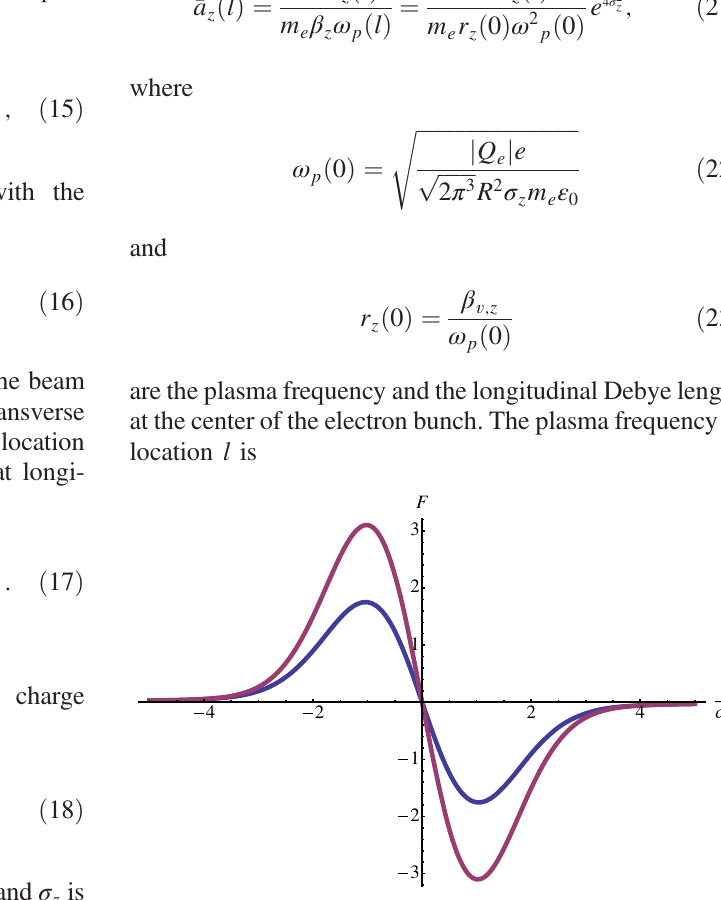
parameters in z